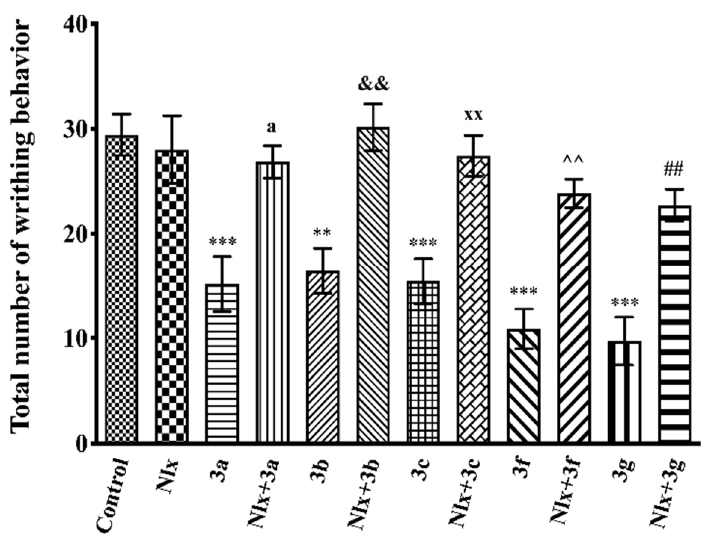
Figure 9. Effect of naloxone (5.48 mg/kg, i.p.) pre-treatment on antinociceptive activity induced by compounds 3a – 3c , 3f , and 3g in the acetic acid-induced writhing test. Significance against control group ** p < 0.01, *** p < 0.001; significance against compound groups: 3a a p < 0.05; 3b && p < 0.01; 3c xx p < 0.01; 3f ^^ p < 0.01; 3g ## p < 0.01. Values are mean ± SEM. One-way ANOVA and post-hoc